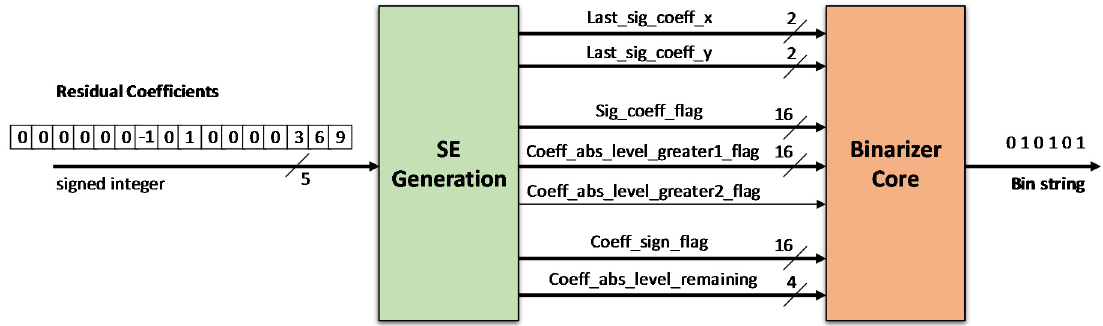
Figure 5. Overall block diagram of residual SE binarization module.